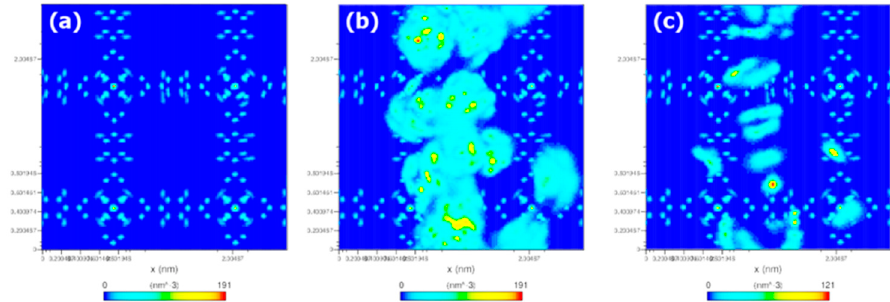
Figure 3. Snapshot of [Chl] + and [SCN] − packed inside IRMOF-1 at ( a ) 0.4% w / w , ( b ) 0.8% w / w , and ( c ) 1.2% w / w of IL loading at 298 K and 1 atm. Colour code: IRMOF-1 (blue); [Chl] + (green); [SCN] − (red).